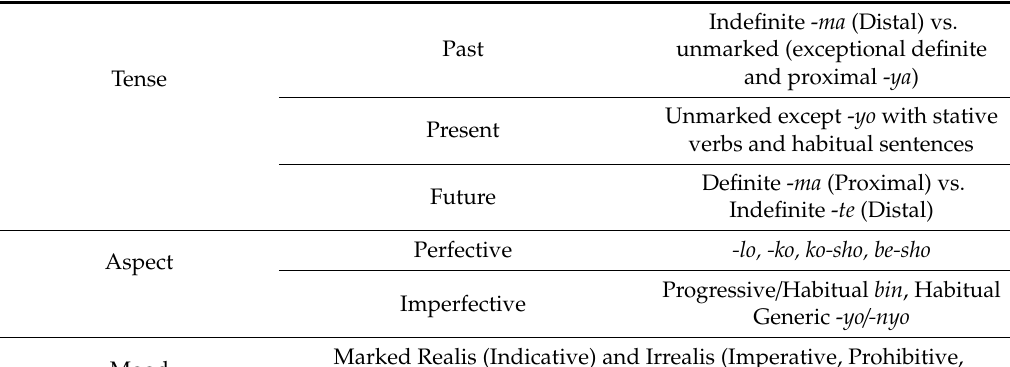
Table 6. Tense–aspect–mood in Rengma.